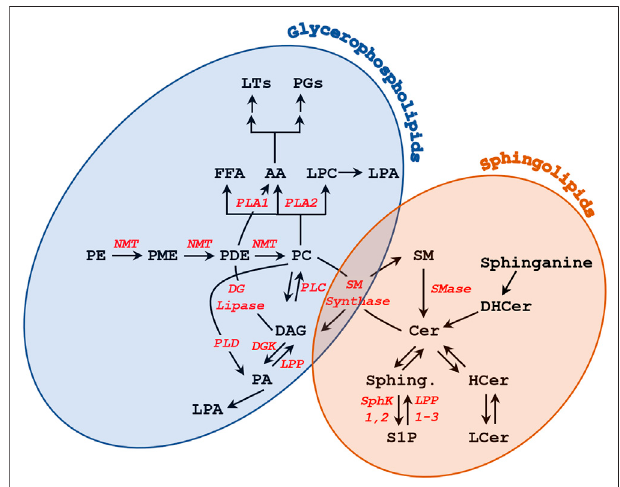
FIGURE 2 | Metabolism of glycerophospholipids and